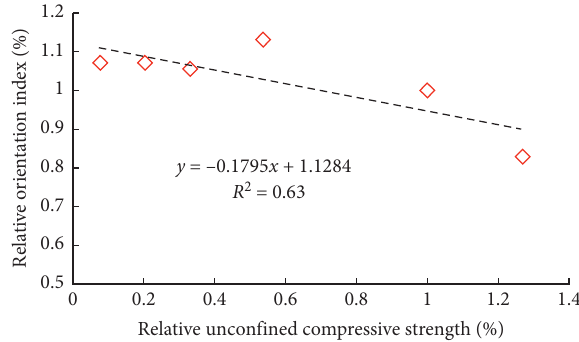
Figure 19: The relationship curve between the relative UCS and relative direction